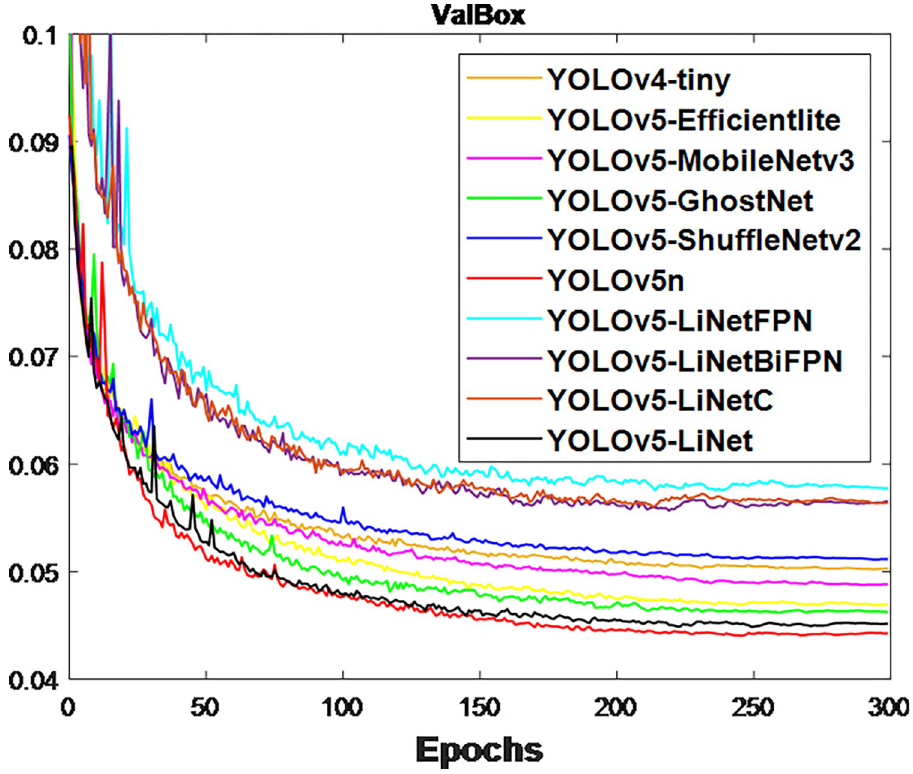
Fig 3. Output for box validation